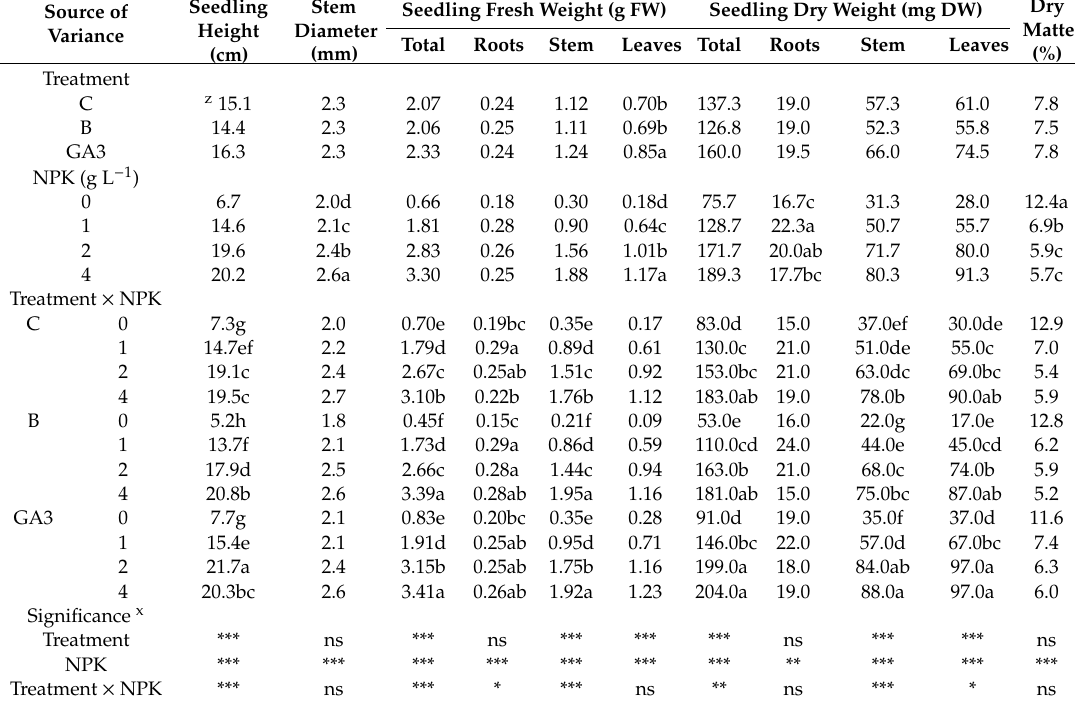
Table 1. E ff ects of the seedling treatments (C, untreated control, B, bacterial biostimulant, GA3, gibberellic acid spray 10 − 5 M) and the nursery fertigation rates (g L − 1 of NPK 20-20-20) on the morphological parameters of Solanum lycopersicum ‘Marmande’ seedlings.